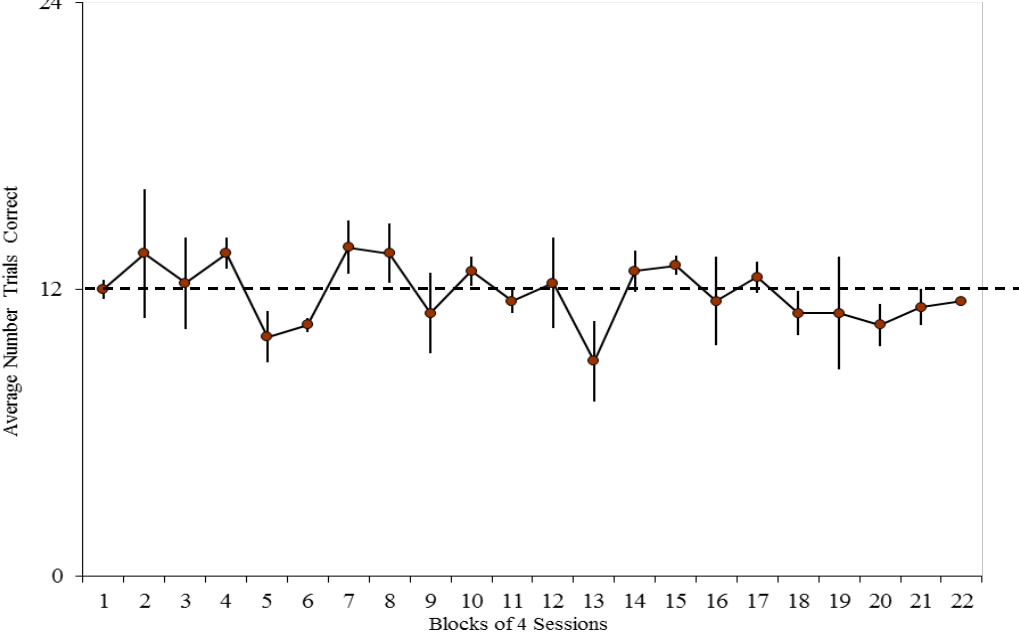
Figure 1 . Average number of correct trials across blocks of four sessions with standard error of the mean. The dotted line indicates chance